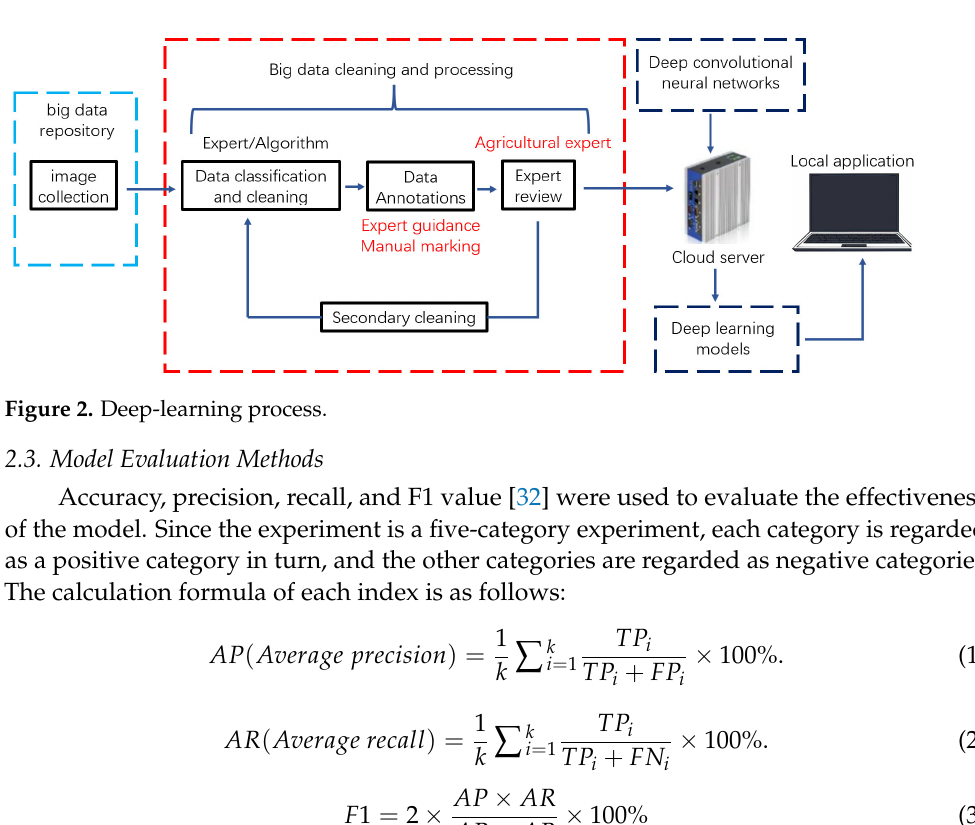
3 of 14 Table 1. Sample assignment of training and test datasets. Level